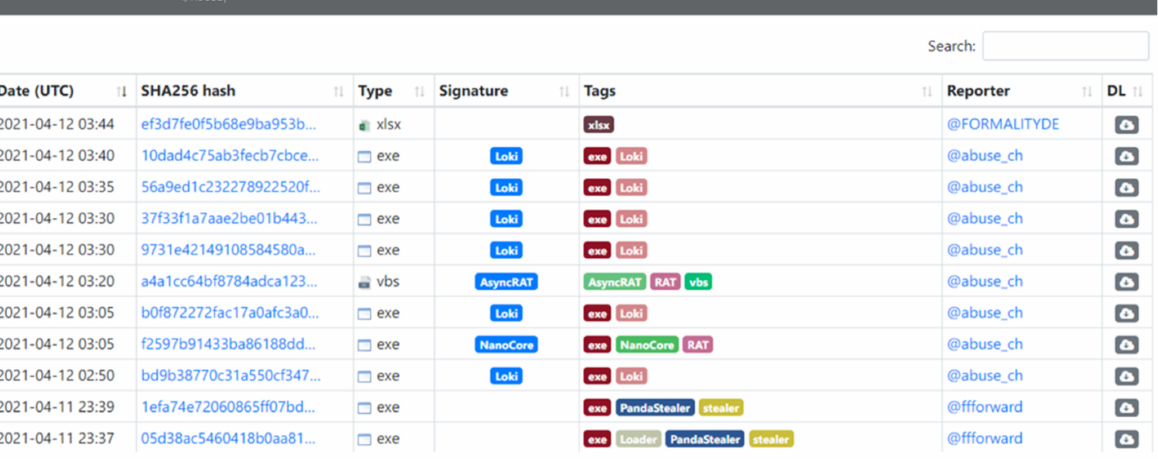
Figure 2. The collected sample data (from Malware